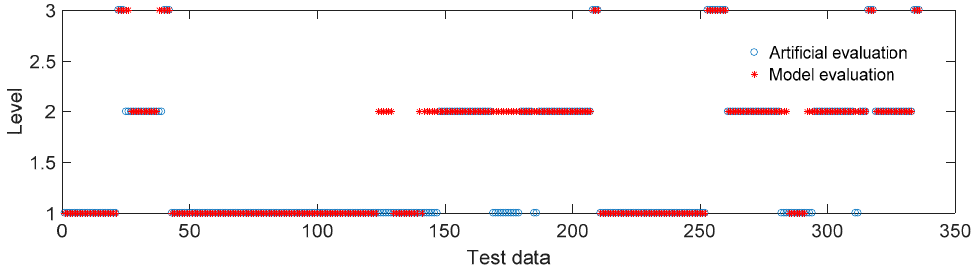
Figure 17. The damage level classification result evaluated by the empirical criteria.